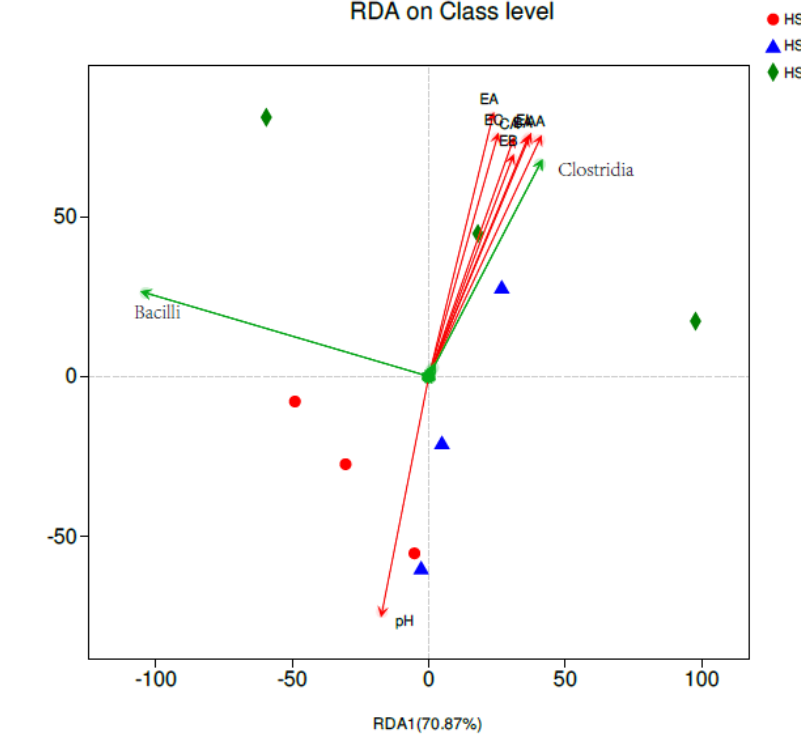
Figure 4. Redundancy analysis of the microbe community structure and aroma components. Arrows indicate the direction and magnitude of measurable variables associated with the microbe community structure.